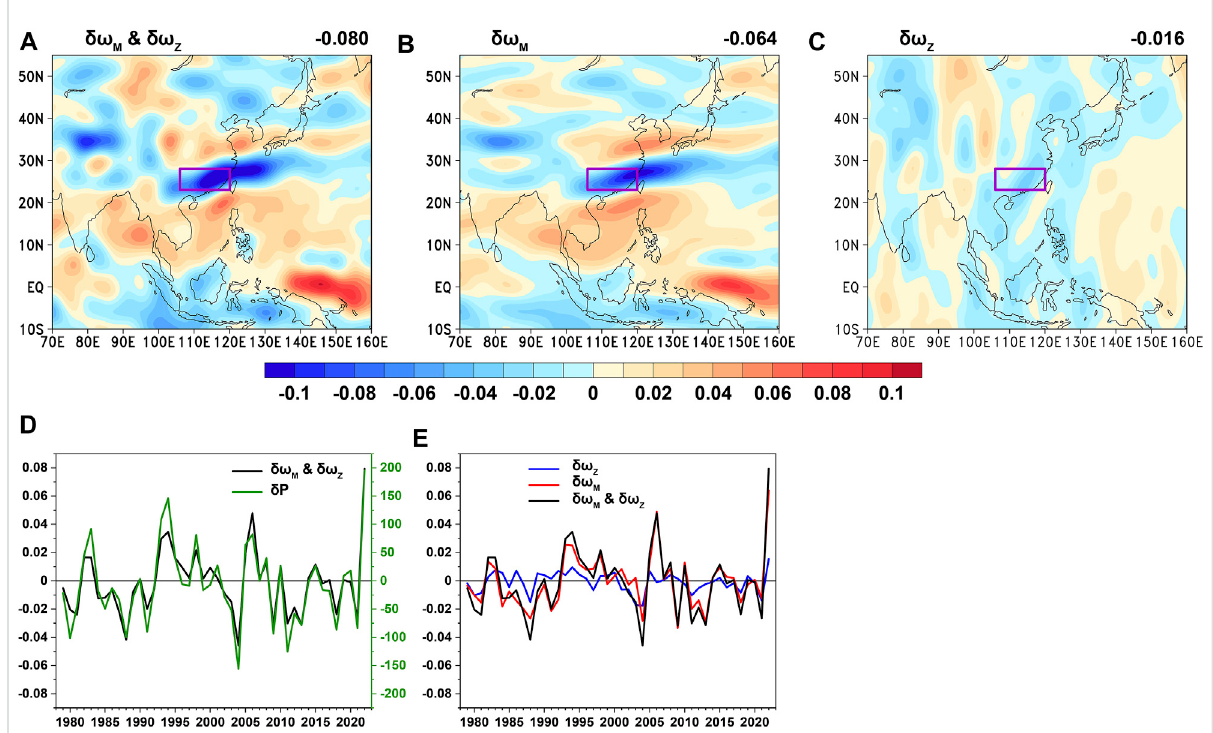
FIGURE 5 (A) Distributionoftheverticalvelocityanomalyduringthe “ DragonBoatWater ” seasonin2022; (B) and (C) arethesameas (A) butforthevertical velocity anomaly of (B) meridional and (C) zonal circulations, respectively. Positive (negative) values in (A – C) represent sinking (rising) motion. The values in the upper right corners of (A – C) represent the regionally-averaged vertical velocity anomalies over SC. (D) Time series of the regionally- averaged vertical velocity anomaly (black line) and rainfall anomaly (green line) over SC during 1979 – 2022. The Y-axis on the left (right) represents the vertical velocity (rainfall) anomaly. (E) Time series of theregionally-averaged vertical velocityanomaly (black line) and vertical velocity anomaly of meridional (red line) and zonal (blue line) circulations over SC during 1979 – 2022. Vertical velocity anomalies in (D) and (E) are multiplied by − 1 for convenience. Units of the vertical velocity anomaly and rainfall anomaly are Pa s − 1 and mm,